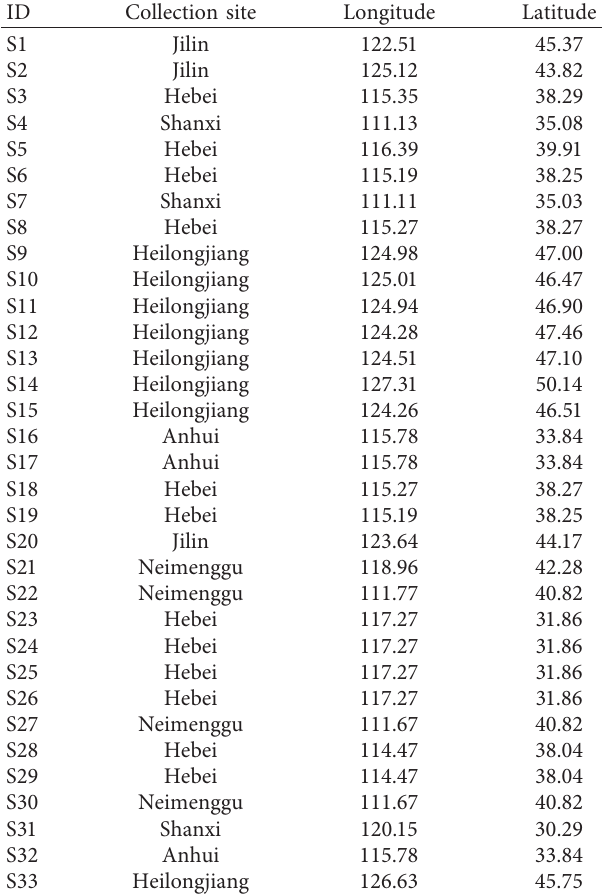
Table 1: The source of 33 batches of S. divaricata .